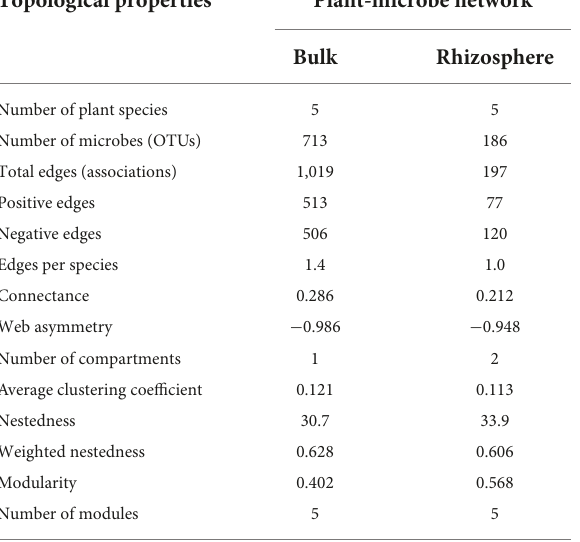
TABLE 1 Topological properties for the IDENs between plants and microbe in bulk and rhizospheric soils. Topological